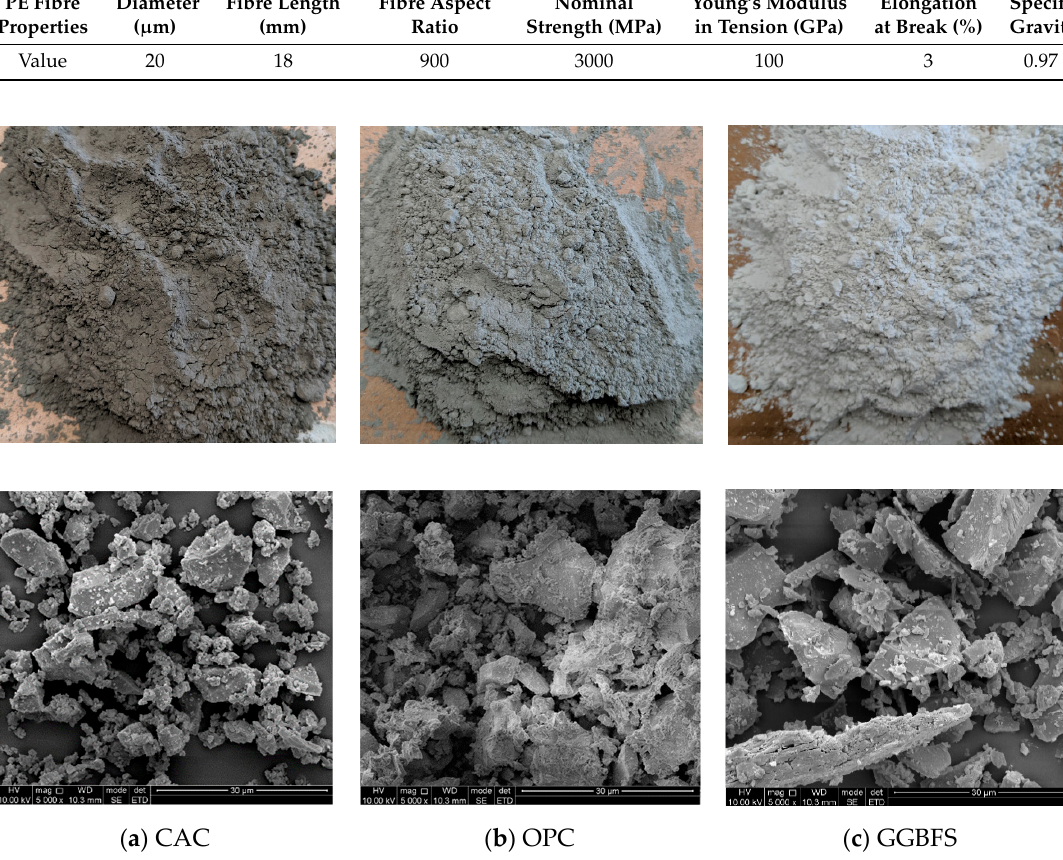
Figure 2. Photo ( above ) and SEM image ( below ) of cementitious material.